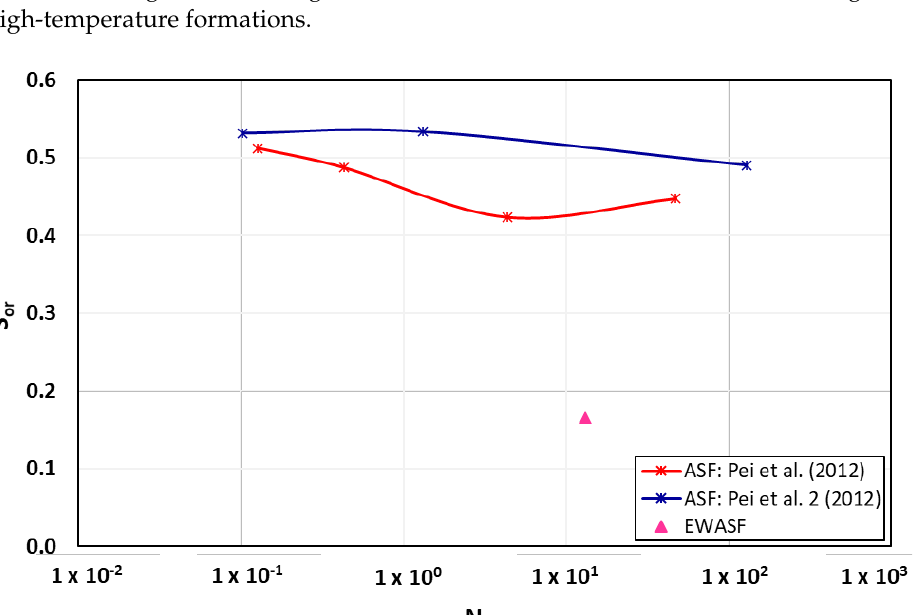
Figure 4. Comparison of capillary desaturation tendency of hybrid EWPF with conventional PF.